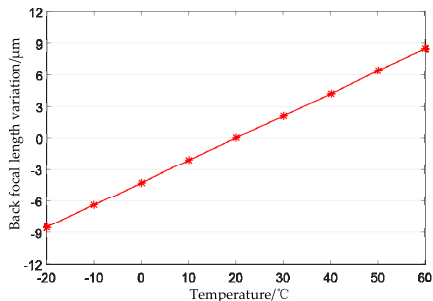
Figure 9. Variation of back focal length with temperature.